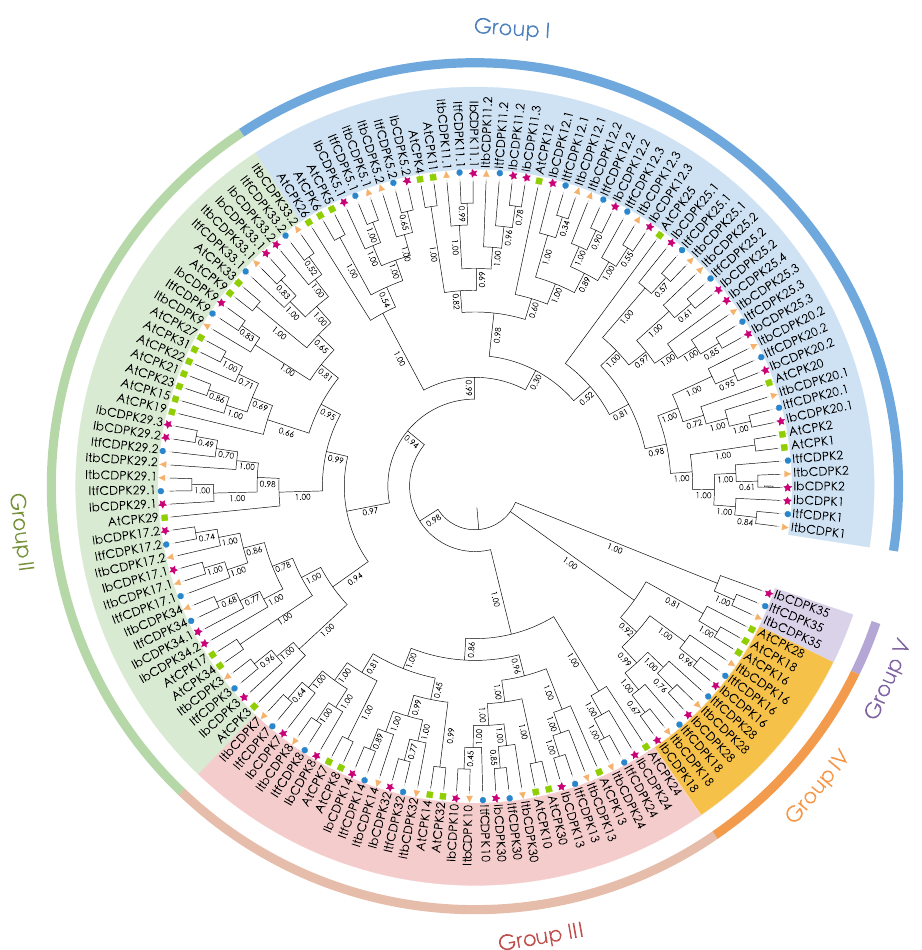
Figure 2. Phylogenetic analysis of the CDPK family in I. batatas , I. trifida , I. triloba , and Arabidopsis . A total of 143 CDPK s were divided into five subgroups (group I to V) according to the evolutionary distance. The pink pentagrams, blue cycles, yellow triangles, and green squares represent IbCDPKs in I. batatas , ItfCDPKs in I. trifida , ItbCDPKs in I. triloba , and AtCPKs in Arabidopsis,